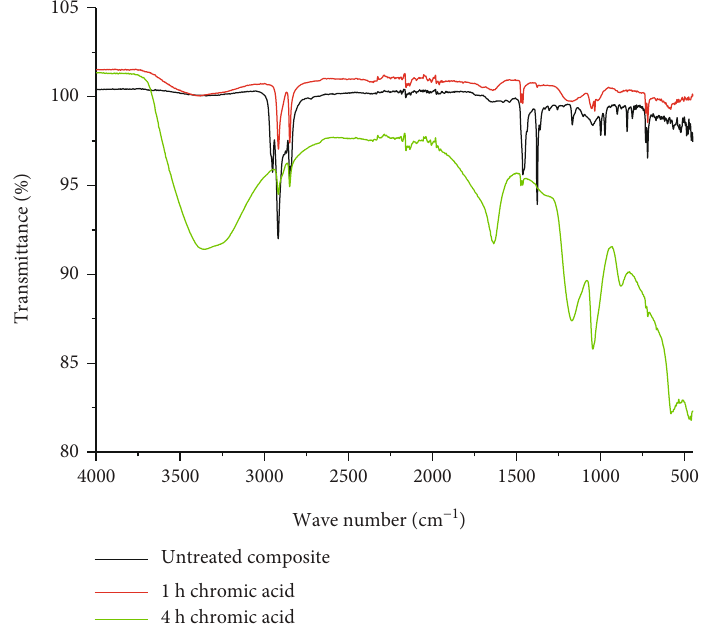
Figure 10: FTIR spectra of untreated and chromic acid etched composite for 1 and 4